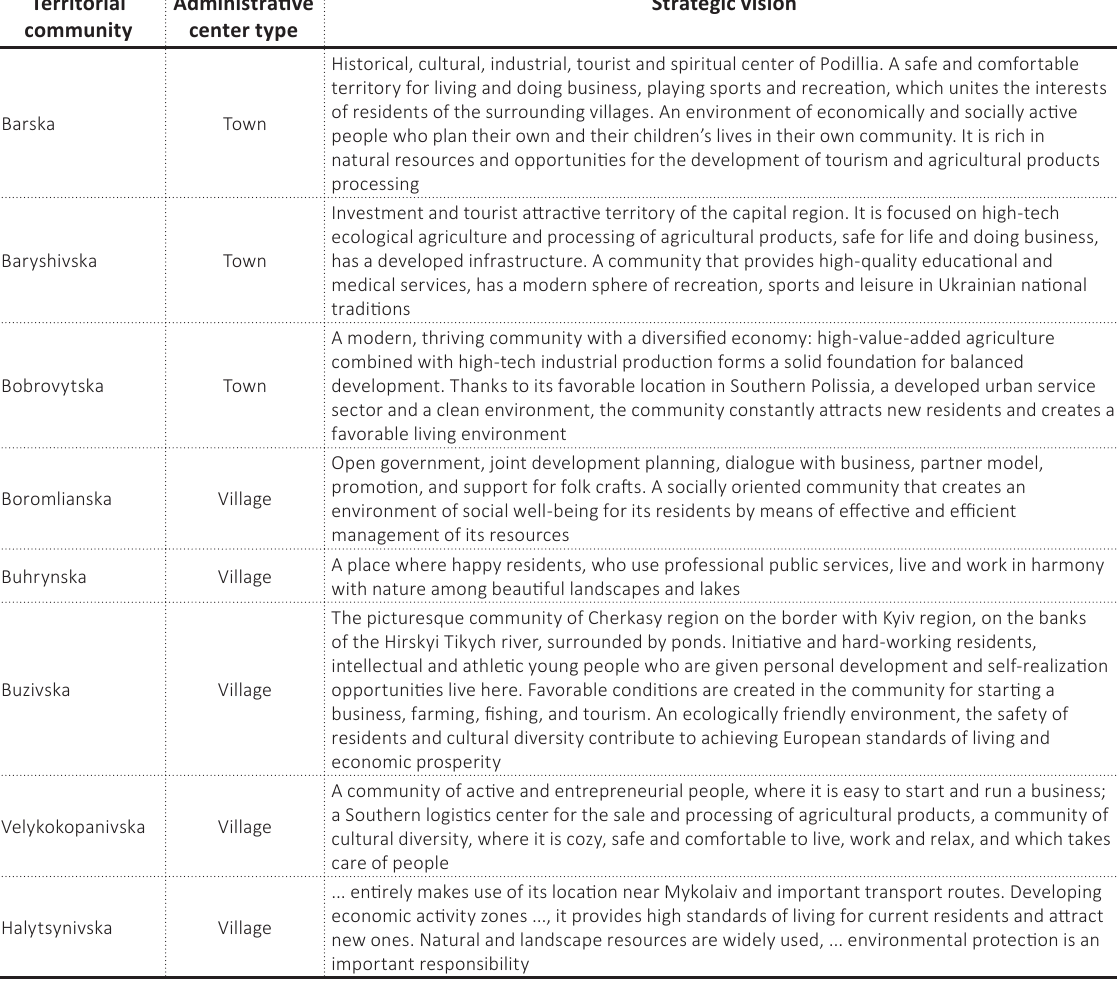
Table A1. Strategic visions of the studied